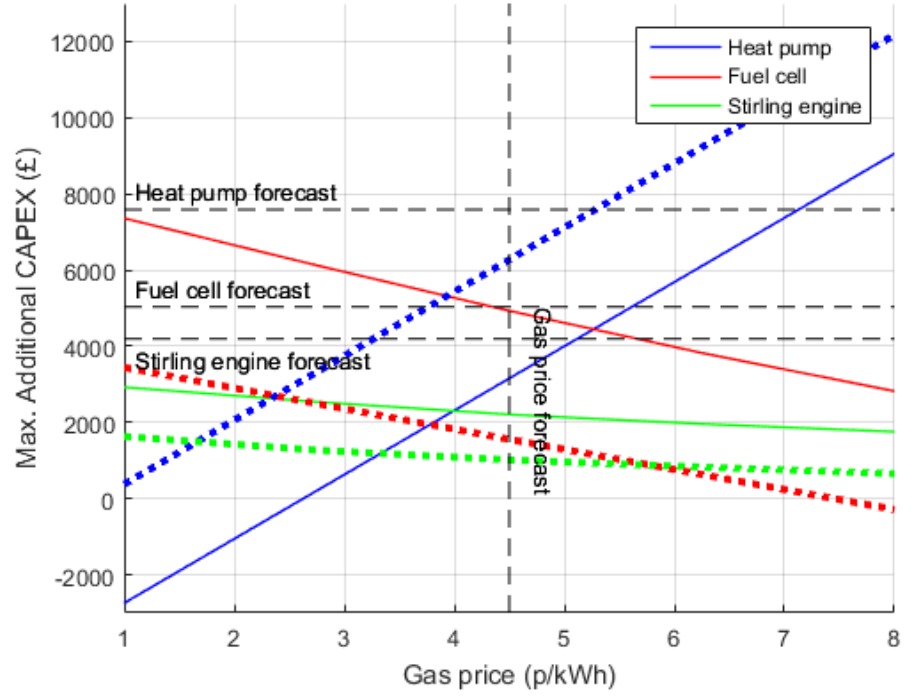
Figure 12. Capital cost sensitivity to natural gas price in the short run (dotted lines) and long run (solid lines) electricity price regime.